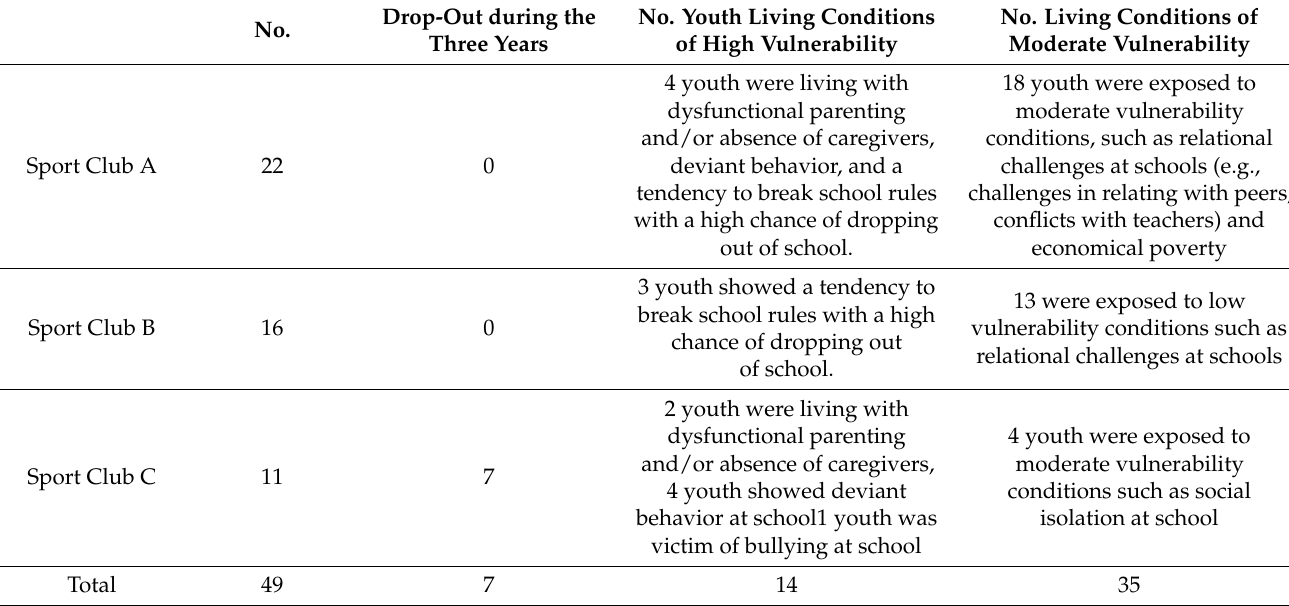
Table 1. Characteristics of